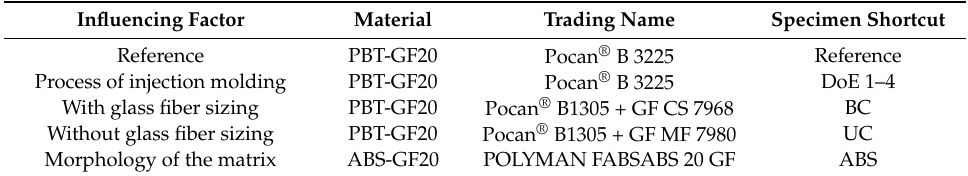
Table 6. Listing of the utilized composites for the specimen processing to examine the influencing factors on the formation of a fiber-matrix